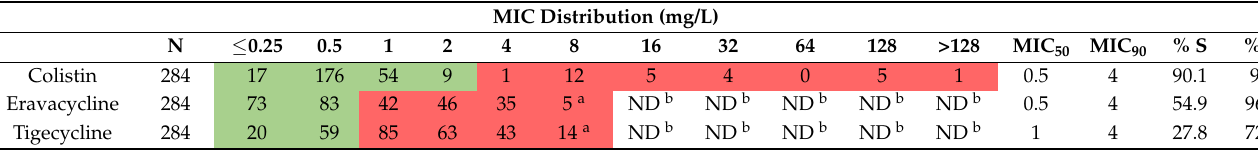
Table 2. MICs distribution for colistin and